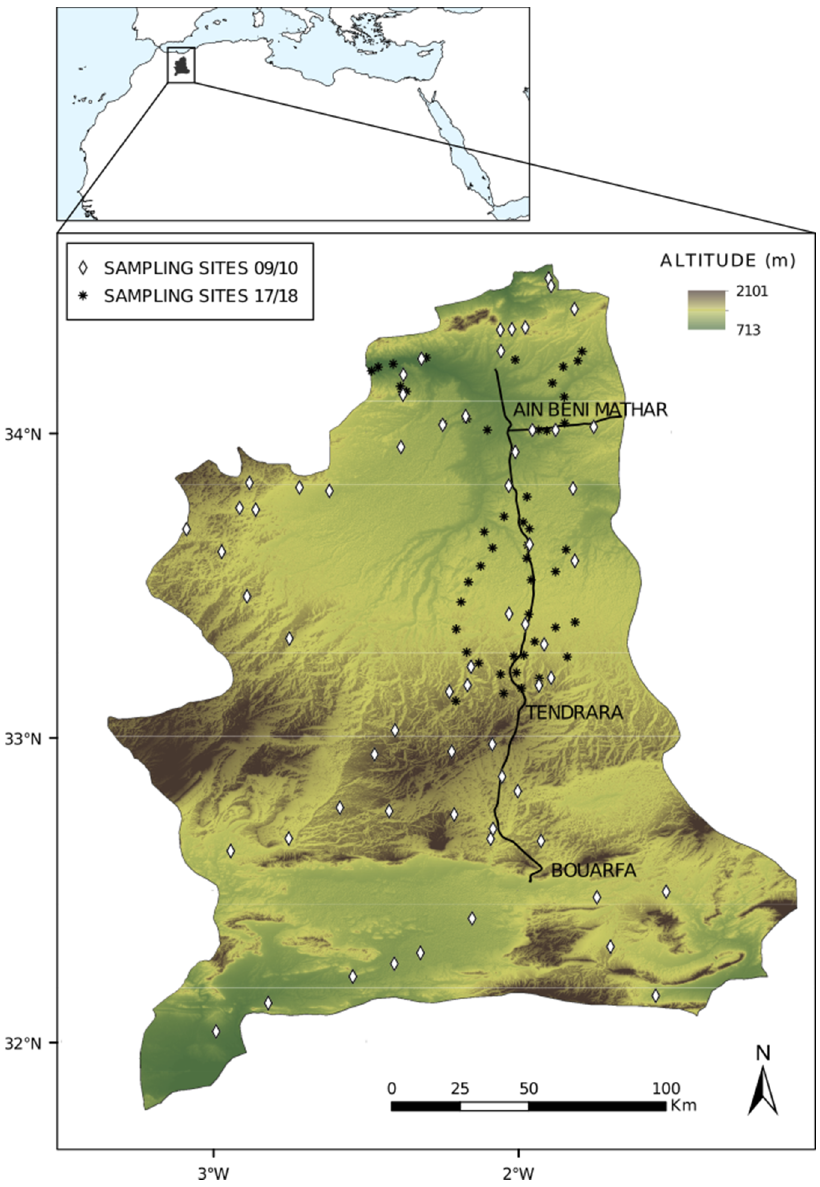
Figure 1. Location of the study area and plant biomass sampling sites (data sources: World Bor- ders [71], Morocco road network [72], SRTM [73]).